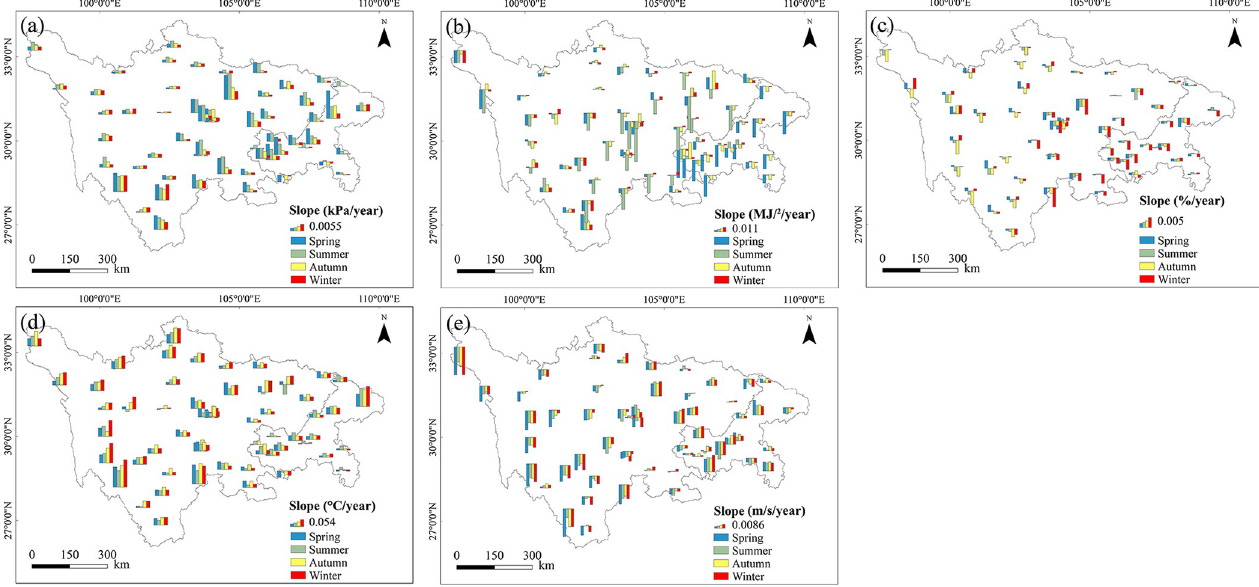
Fig 6. Same as in Fig 2, but for the five meteorological variable: (a) vapor pressure deficit; (b) net radiation; (c) relative humidity; (d) air temperature; (e) wind speed.